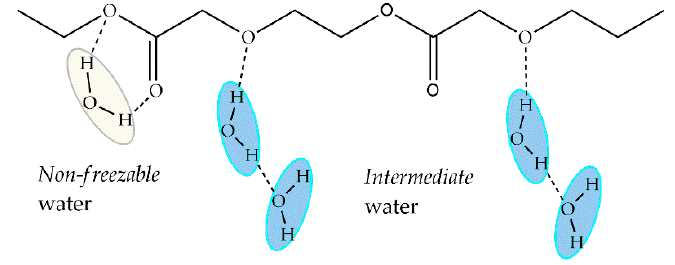
Figure 15. Proposed structure of non-freezable (yellow) and intermediate (blue) water sorbed on poly(dioxanone) (PDO).